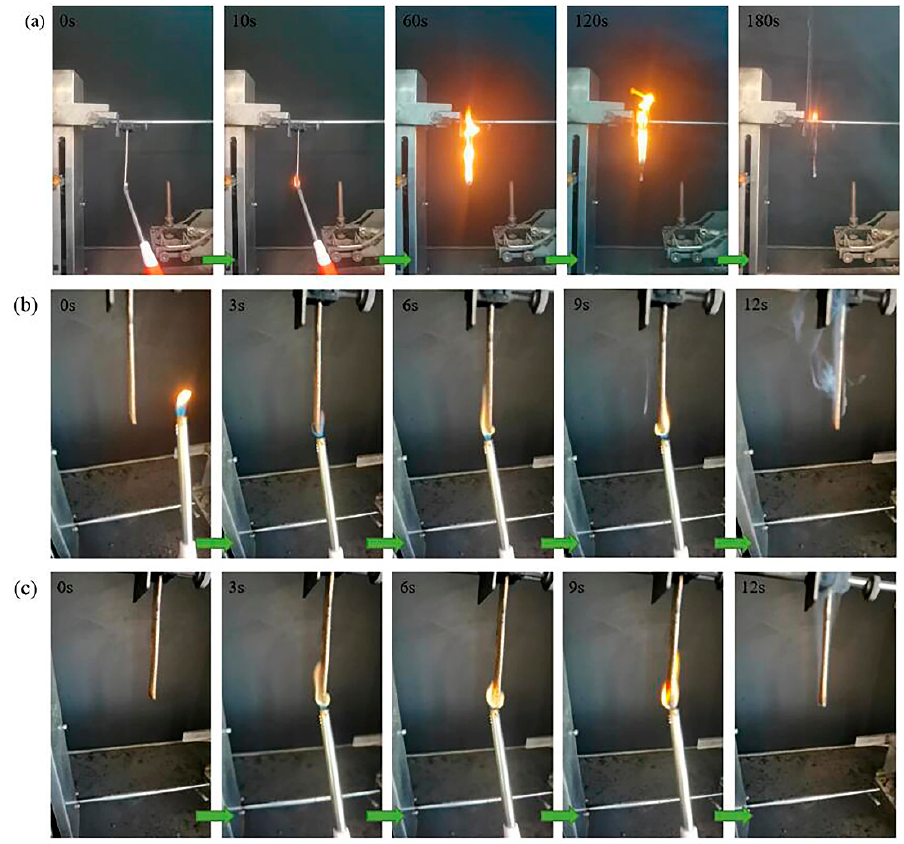
Figure 5. ( a ) Vertical combustion behavior of FNFs, ( b , c ) vertical combustion behavior of FNFs-4 ignited twice.